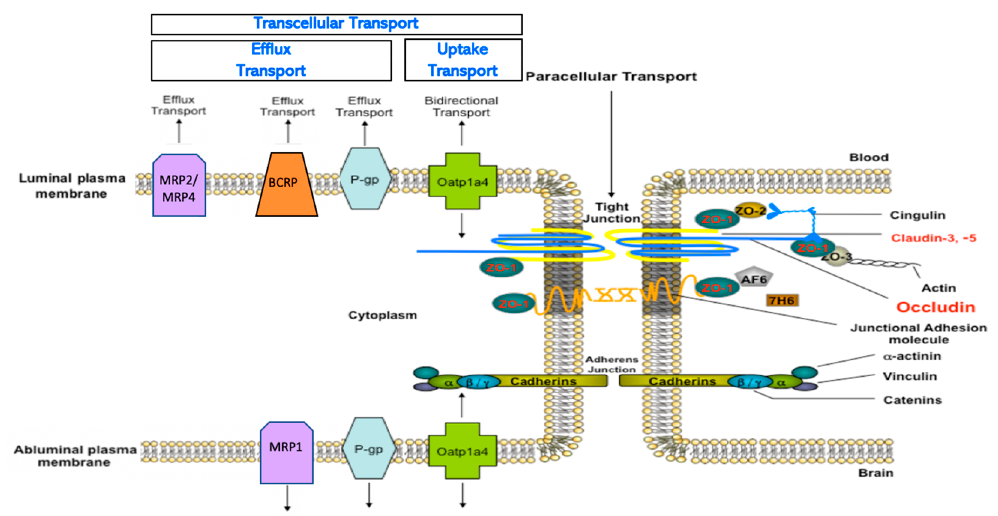
Figure 2. Physical and biochemical characteristics of the blood-brain barrier (BBB). Physiologically, paracellular diffusion is restricted by tight junction protein complexes and adherens junctions.